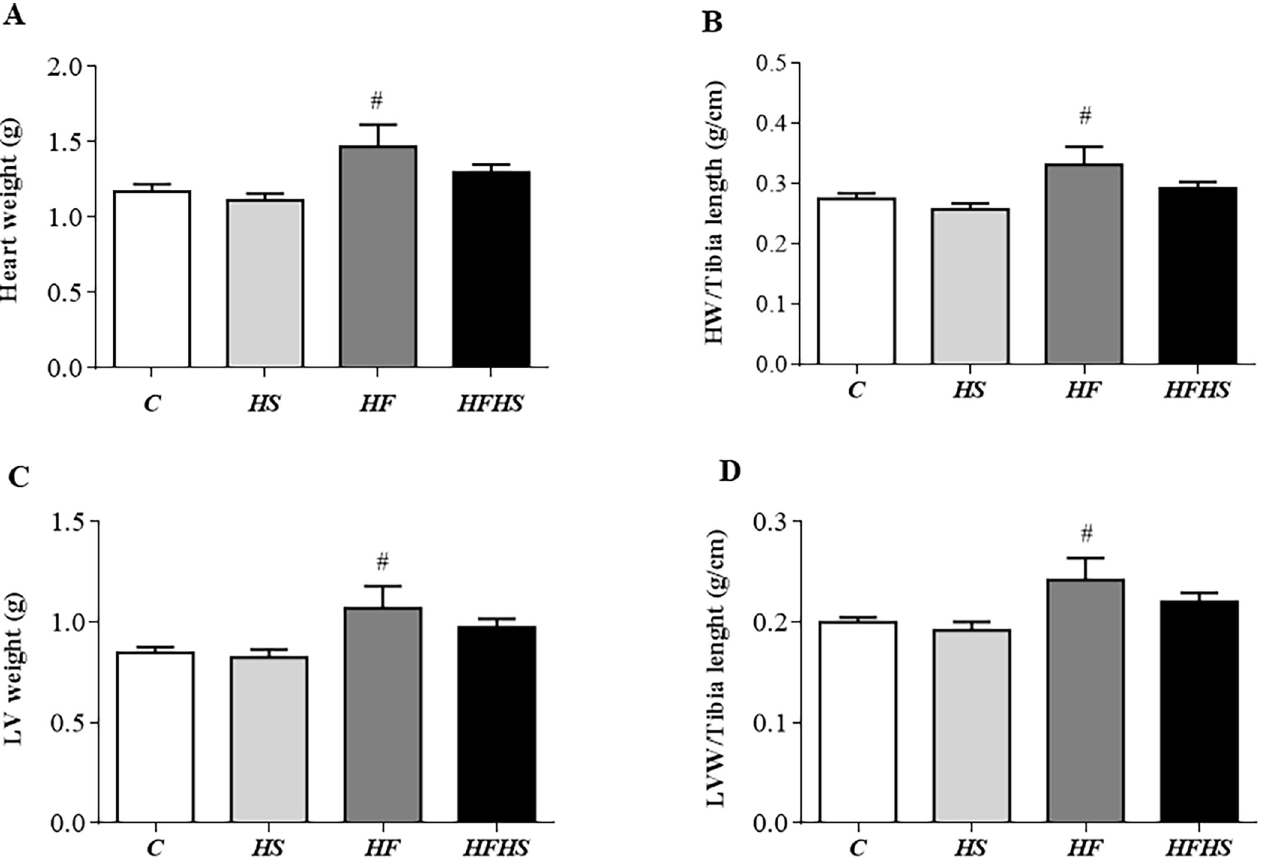
Fig 1. Effect of different diet composition on cardiac remodeling. Data are shown as mean ± SEM. Control diet—(C; n = 5); high-sugar diet—(HS; n = 8); high-fat diet—(HF; n = 5), and high-fat and high-sugar diet (HFHS; n = 6). HW: heart weight; LW: left weight. p < 0.05 vs. # HF vs. HS. One-way analysis of variance (ANOVA) followed by the Tukey post hoc